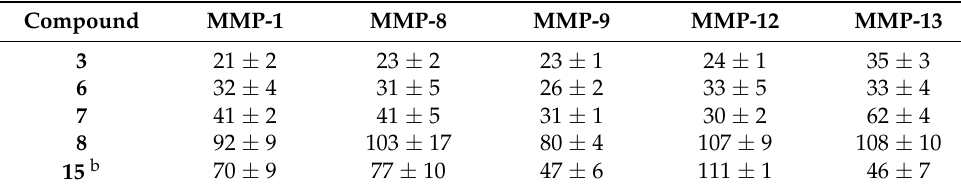
Table 5. MMP inhibitory activity a of the compounds tested (IC 50 values in µ M).